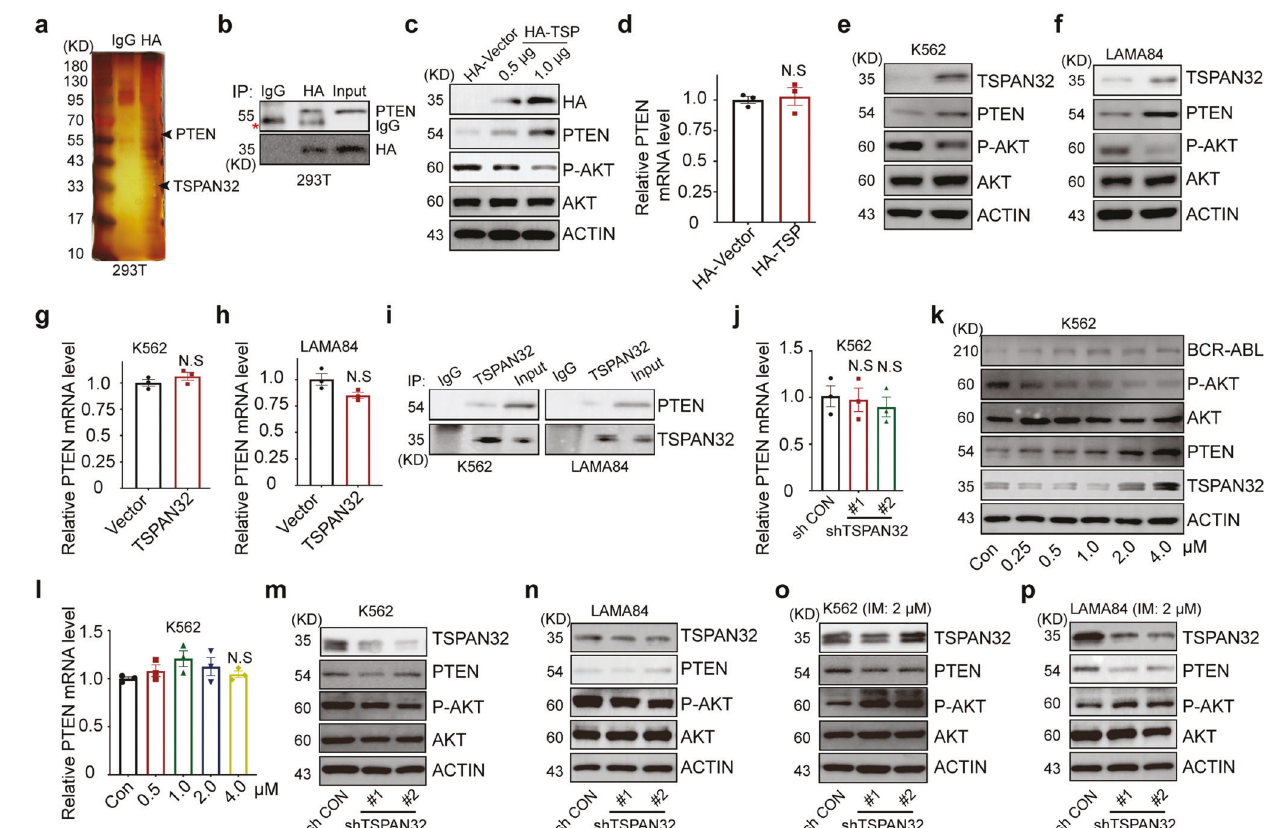
Fig. 7 TSPAN32 interacts with PTEN protein and enhances its function. a The lysis of HEK-293T cells transfected with HA-TSPAN32 was performed for co-immunoprecipitation with the HA antibody or an IgG control, and the product was puri fi ed using a PAGE gel for mass spectrometry assay. b HEK-293T cell lysis was performed for co-transfected HA-TSPAN32 and PTEN for immunoprecipitation (with anti-HA and IgG) and immunoblotting (with anti-HA and anti-PTEN). c , d Indicated amount HA-TSPAN32 was transfected into HEK-293T cells for 24 h, RT- PCR for PTEN mRNA, and immunoblotting for TSPAN32, PTEN, P-AKT and total AKT, ACTIN served as the loading control. e – h K562 and LAMA84 with ectopic TSPAN32 expression; p-AKT, total AKT, PTEN and TSPAN32 were analyzed by immunoblotting, ACTIN served as the loading control, PTEN mRNA was analyzed by RT-PCR. i K562 and LAMA84 were treated with 2 μ M Imatinib for 24 h, Immunoprecipitation (with anti-TSPAN32 and IgG) and immunoblotting analysis (with anti-TSPAN32 and anti-PTEN). j mRNA levels for PTEN were examined in K562 cells transfected with TSPAN32 shRNA. k Immunoblotting was performed for BCR-ABL, p-AKT, total AKT, PTEN and TSPAN32 in K562 cells treated with Imatinib at the indicated concentration for 24 h, ACTIN served as the loading control. l K562 cells treated with Imatinib at indicated concentration for 24 h, PTEN mRNA was analyzed with RT-PCR. m – p K562 and LAMA84 cells infected with TSPAN32 shRNA or control vector were treated with or without Imatinib for 24 h, immunoblotting was conducted for TSPAN32, PTEN, p-AKT, total AKT as indicated, ACTIN served as the loading control. N.S, no signi fi cance; error bars denote mean ± cell lines (Fig. 2g, h). Previously studies have shown overlapping biological functions and complementary role among Tetraspanin family members, 27 thus, we speculate that other tetraspanin members might compensate for the function loss of TSPAN32. Additionally, when we highly expressed TSPAN32 with BCR-ABL in a CML mouse model, we found that TSPAN32 signi fi cantly prevented CML progression (Supplementary Fig. 1). Technically, we found that the expression density of BCR-ABL was lower in BCR-ABL-TSPAN32 co-expressing vector in comparison to that in BCR-ABL alone vector (Supplementary Fig. 1a), which may lead to